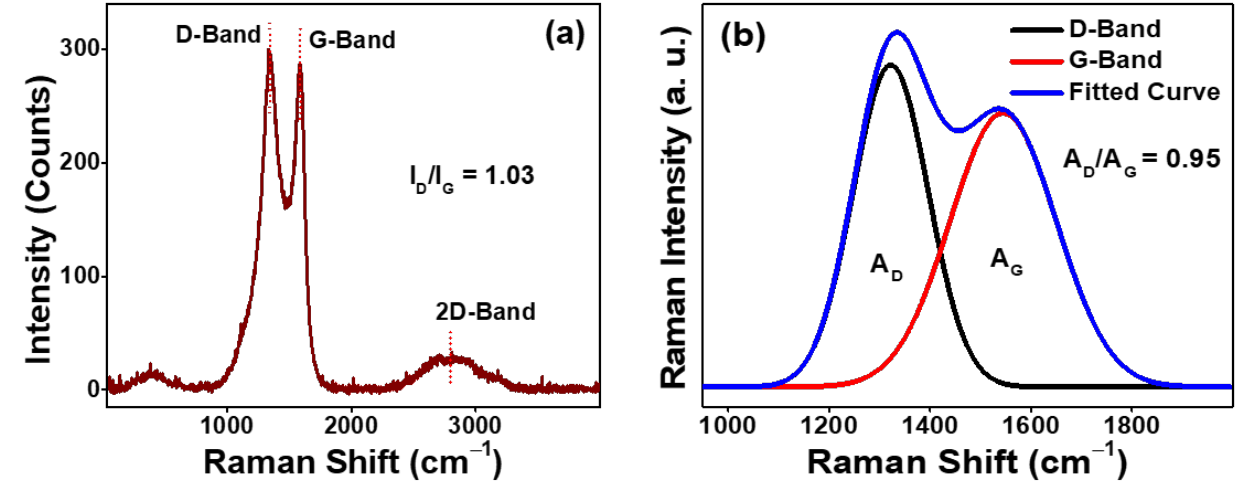
Figure 3. ( a ) Raman spectrum and ( b ) Raman spectrum with deconvolution of D-band/G-band of synthesized H-PCM.